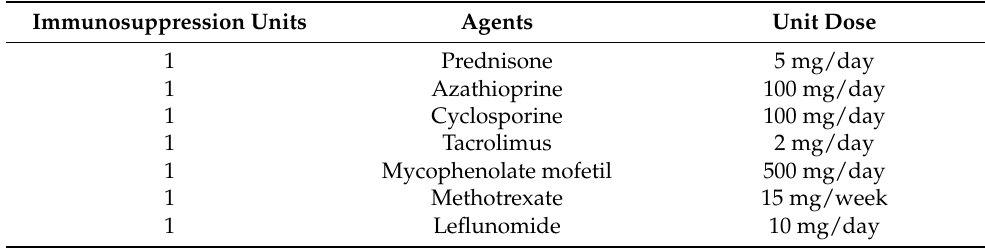
Table 1. A scale modified from Vasudev et al. to quantify the immunosuppressive medication (9). One unit of immunosuppression was assigned to the corresponding doses of